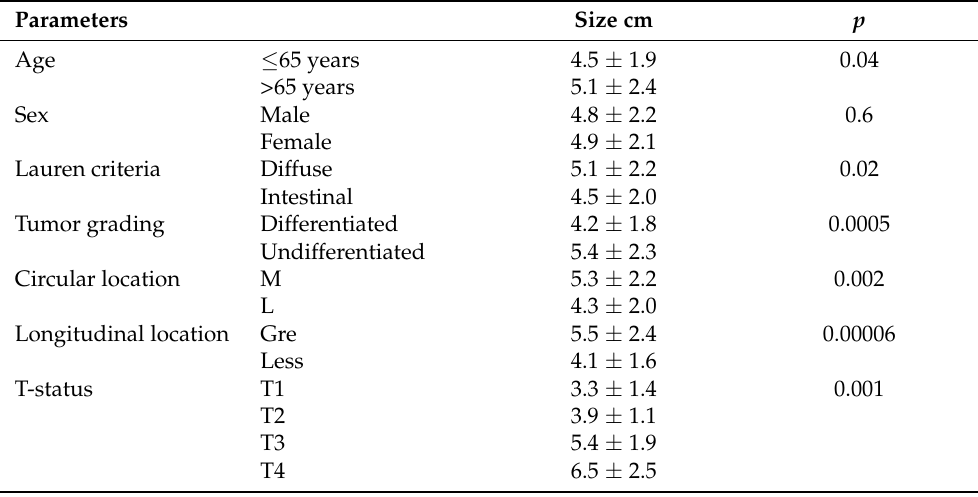
Table 2. Tumor size in relation to the clinical, anatomical and pathological parameters